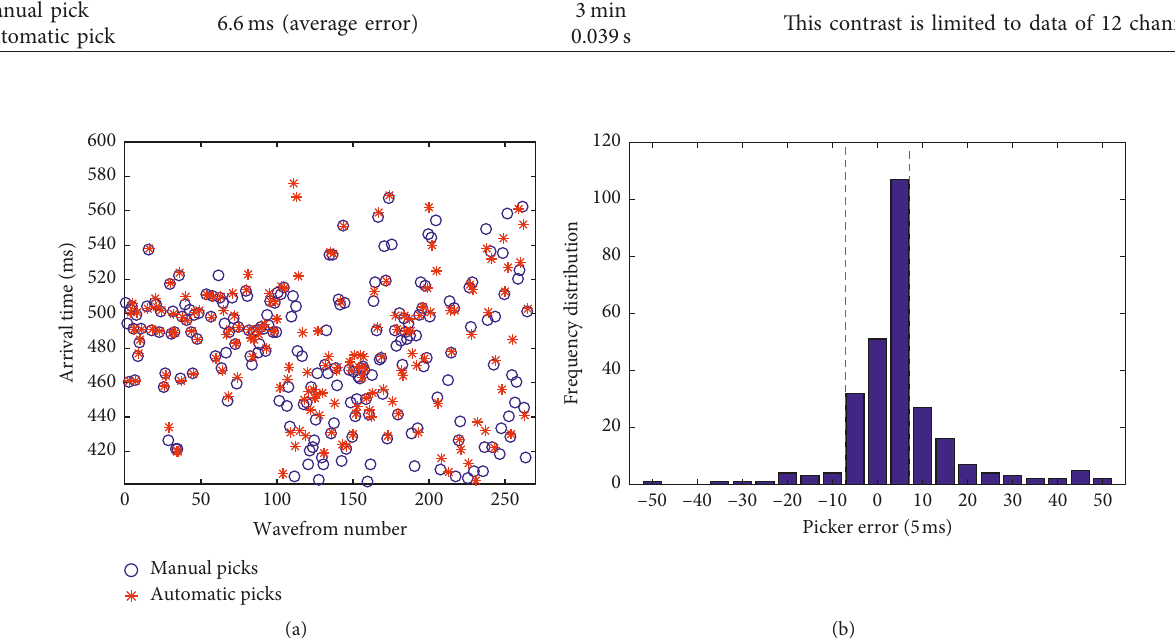
Figure 14: P arrival residual plot for the algorithm. (a) Comparison of automatic pick and manual pick methods. (b) Error statistical analysis of automatic